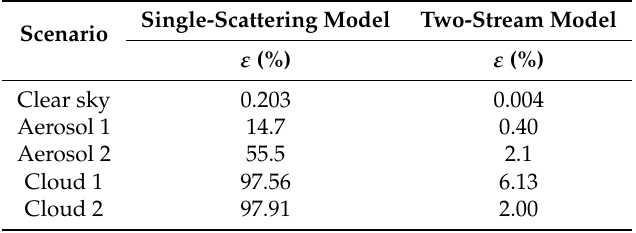
Table 3. Mean relative error ε for the low-stream models (single-scattering and two-stream models) compared with the multi-stream model for the CO 2 weak band.